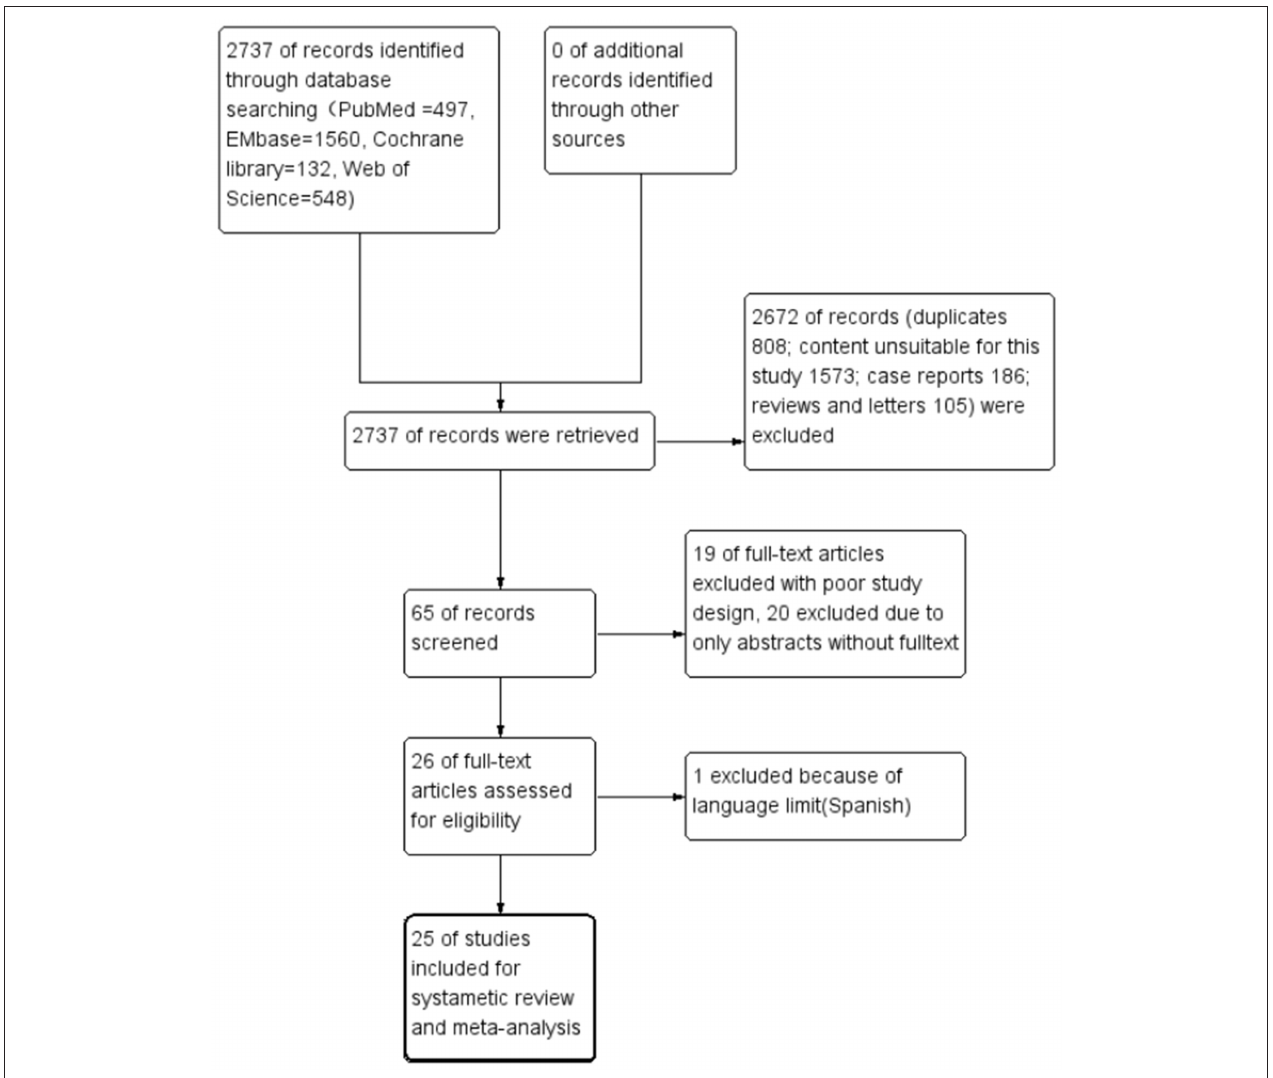
FIGURE 1 | Flowchart of study